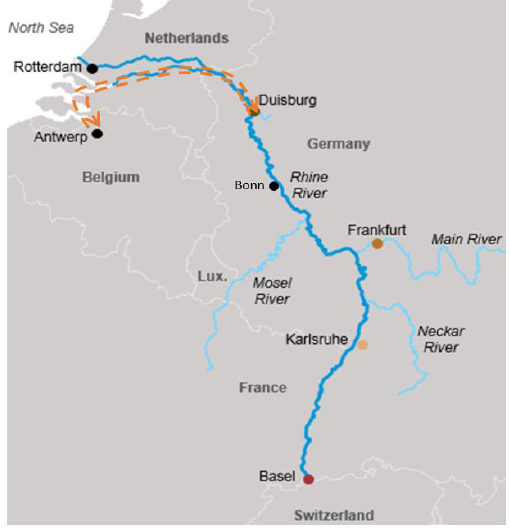
Figure 2. Operating Area of the Case